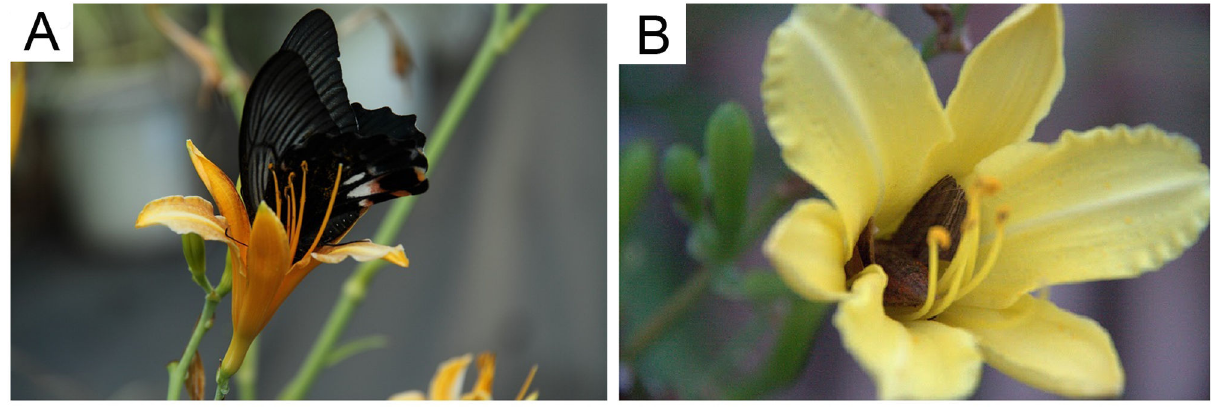
Figure 1. Flowers of H. fulva and F2 hybrid. (A) A swallowtail butterfly Papilio xuthus visiting a H. fulva flower. (B) A hawkmoth Theretra japonica visiting a F2 hybrid